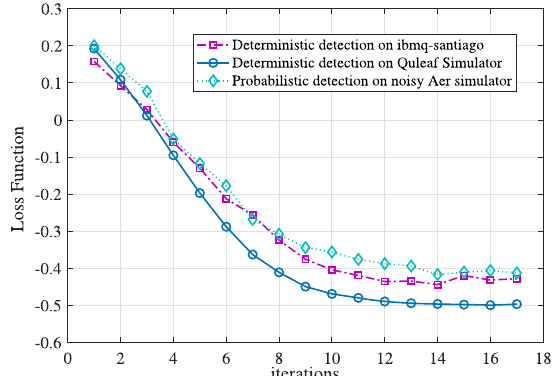
Fig. 5 Estimated minimum eigenvalue λ min by VED using the reduction criterion on the Bell state Φ j i . The red square curve records the results of Algorithm 1 on ibmq-santiago with shots = 8192 for each circuit evaluation. The cyan diamond curve records the results of Algorithm 2 by choosing δ = 0.1 and ε = 0.01. The blue circle curve records the numerical results on the Baidu Quantum Leaf platform 89 . Learning rate in the gradient descent algorithm is set to be LR = 0.5.